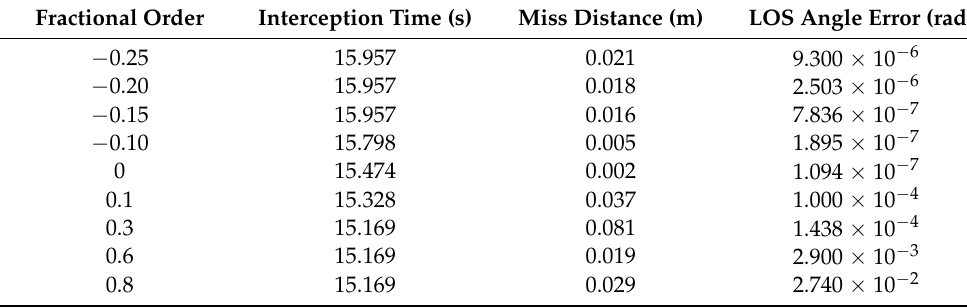
Figure 2. Simulation results with α = 0.1,0.3,0.6,0.8 in case 1. Table 3. Interception times, miss distances, and LOS angle errors of the proposed guidance laws under different fractional orders in case